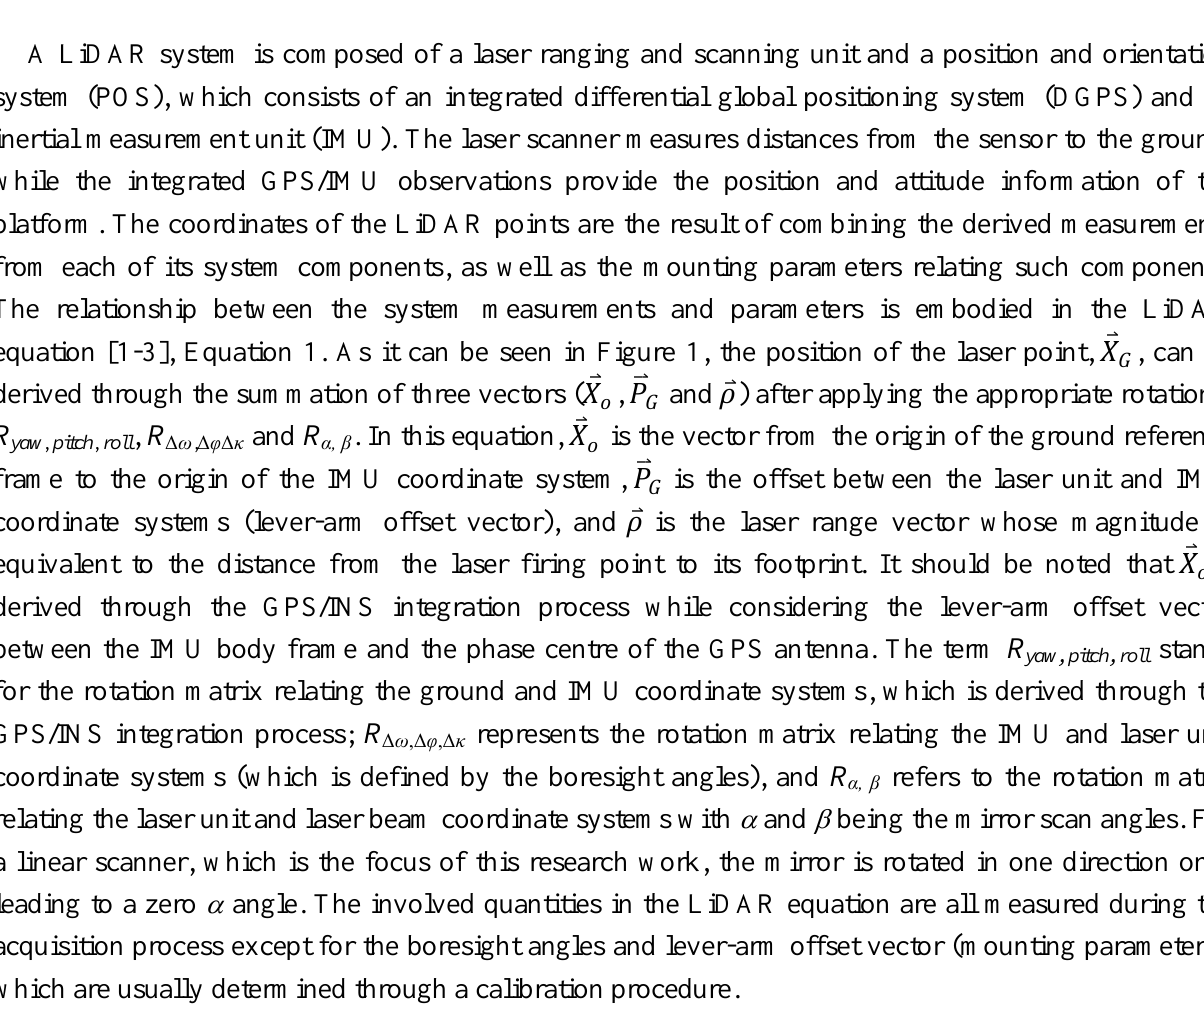
Figure 1. Coordinate systems and involved quantities in the LiDAR